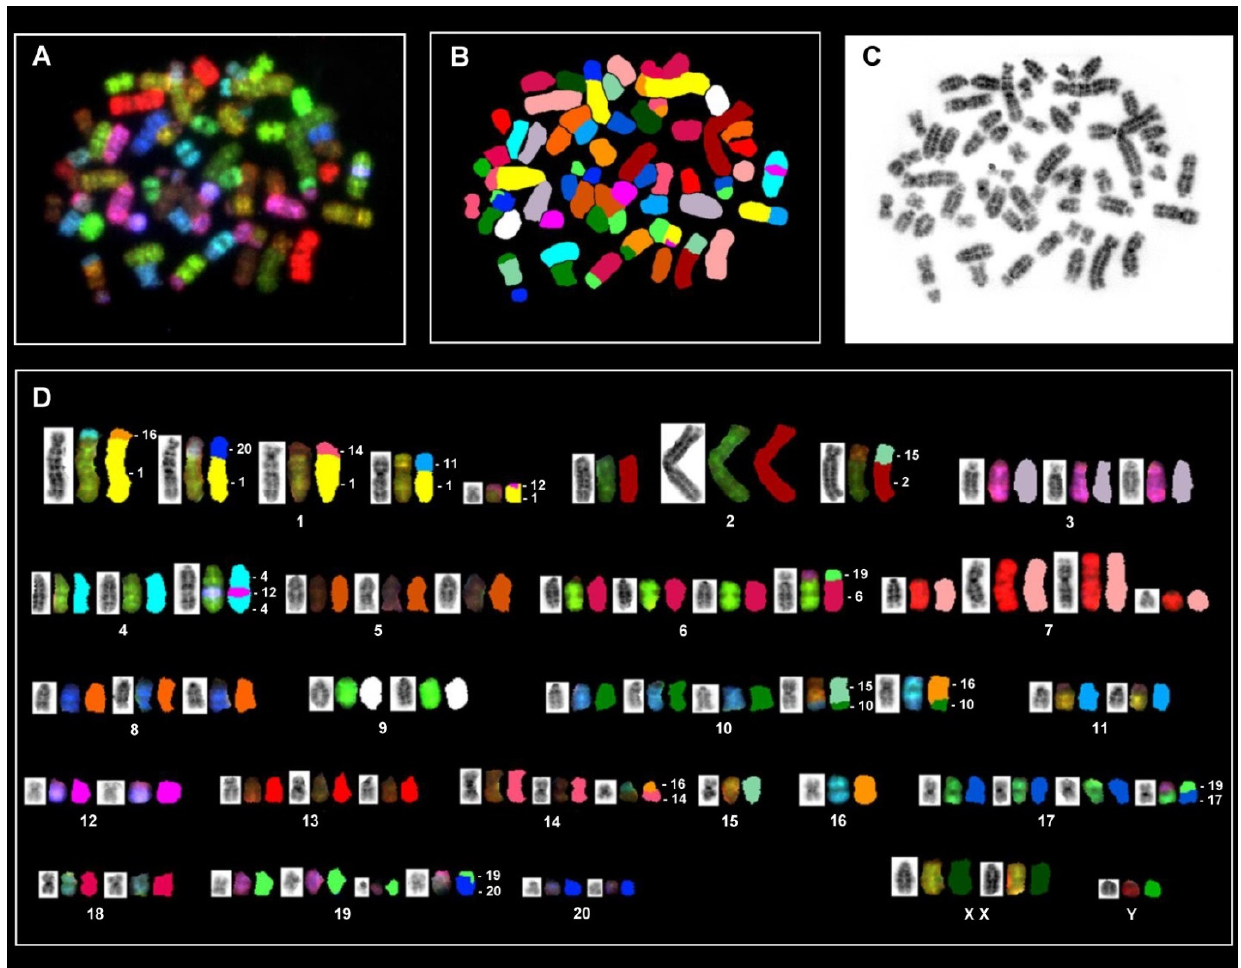
Figure 9. Spectral karyotyping of a rat CFSC-2G cell metaphase. ( A ) RGB image after hybridiza- tion with the SKY probe cocktail. ( B ) Classified pseudo-colored image of the same metaphase. ( C ) Inverted DAPI-stained image. ( D ) Karyotype of the metaphase showing spectrally classified, pseudo-colored chromosomes ( right ) compared with its inverted DAPI-stained chromosomes ( left ) and corresponding RGB image ( middle ). Specific chromosomes involved in the rearranged chromosomes are indicated. Based on the SKY analysis the CFSC-2G karyotype can be described as: